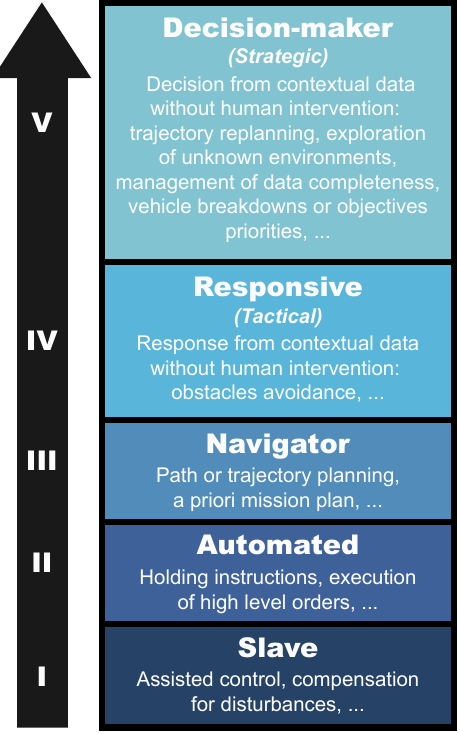
Figure 8. Levels of automation of an exploration